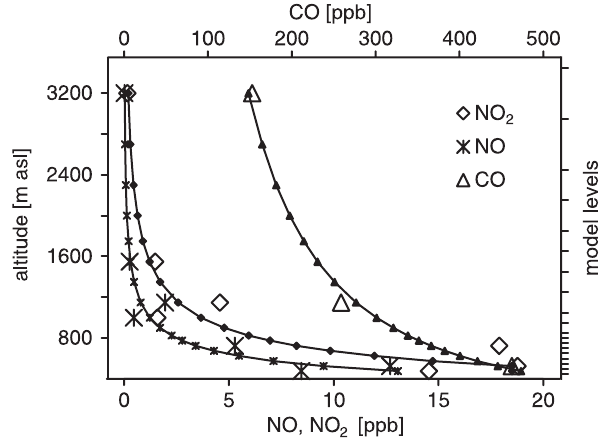
Fig. 6. Measurements of NO, NO 2 and CO at different sites on 9 February, 11 to 13 UTC, and initial values prescribed to the 18 levels of Metphomod by fitting a power law to the measured con- centrations (the value in the lowest model layer was replaced with the value from the second lowest